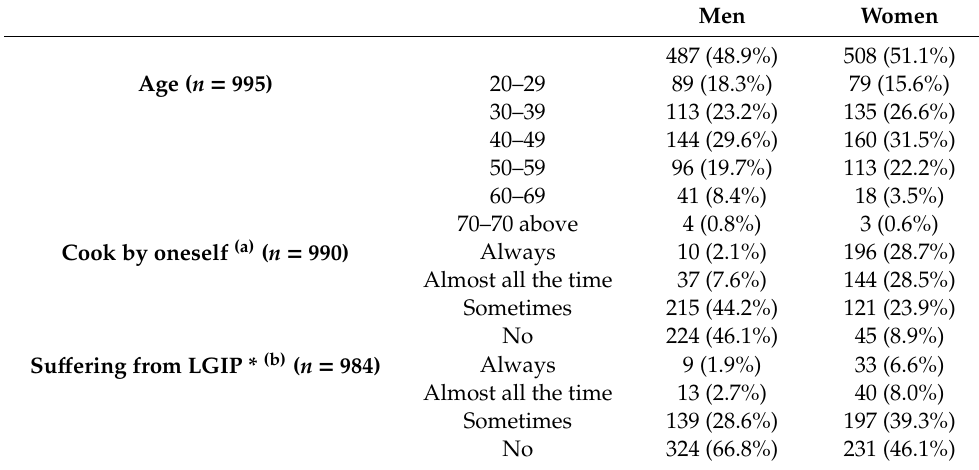
Table 1. Characteristics of the analyzed population ( n =